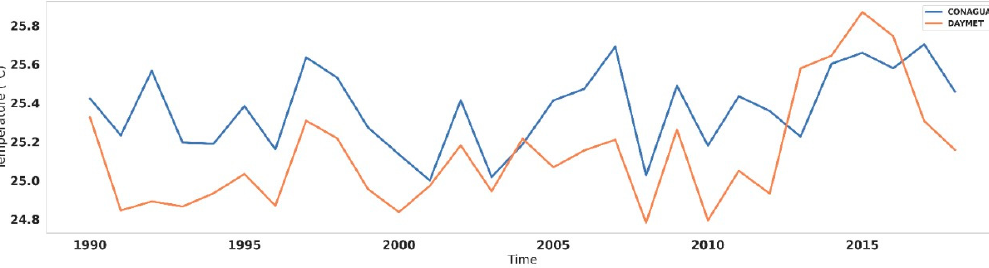
Figure 3. Temperature over time.